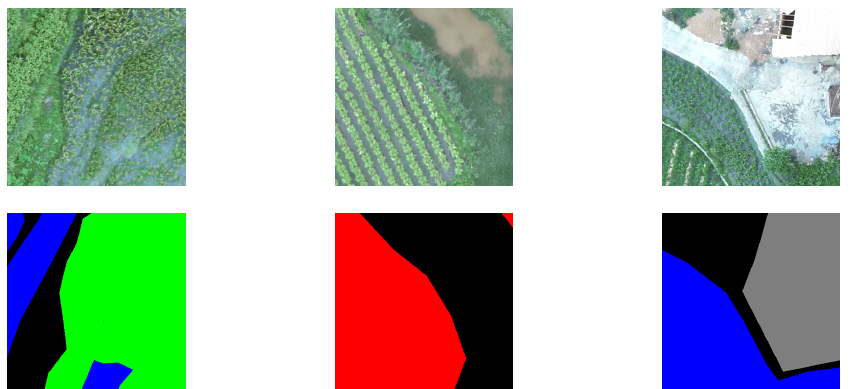
Figure 5. Cropped remote sensing images. The top row is the RGB image, and the bottom row is the corresponding label, in which black represents the background, red represents flue-cured tobacco, green represents corn, blue represents barley, and gray represents